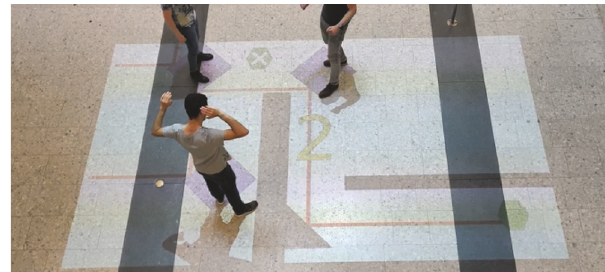
Figure7:Reflect:threeplayerscollaboratingtoguidethelaserbeam towards the target.